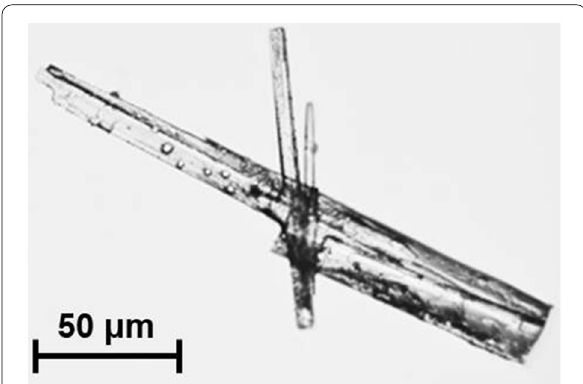
Fig. 2 A photograph of spiculisporic acid crystals. The product was purified from T. trachyspermus NBRC 32238 using ethanol elution and